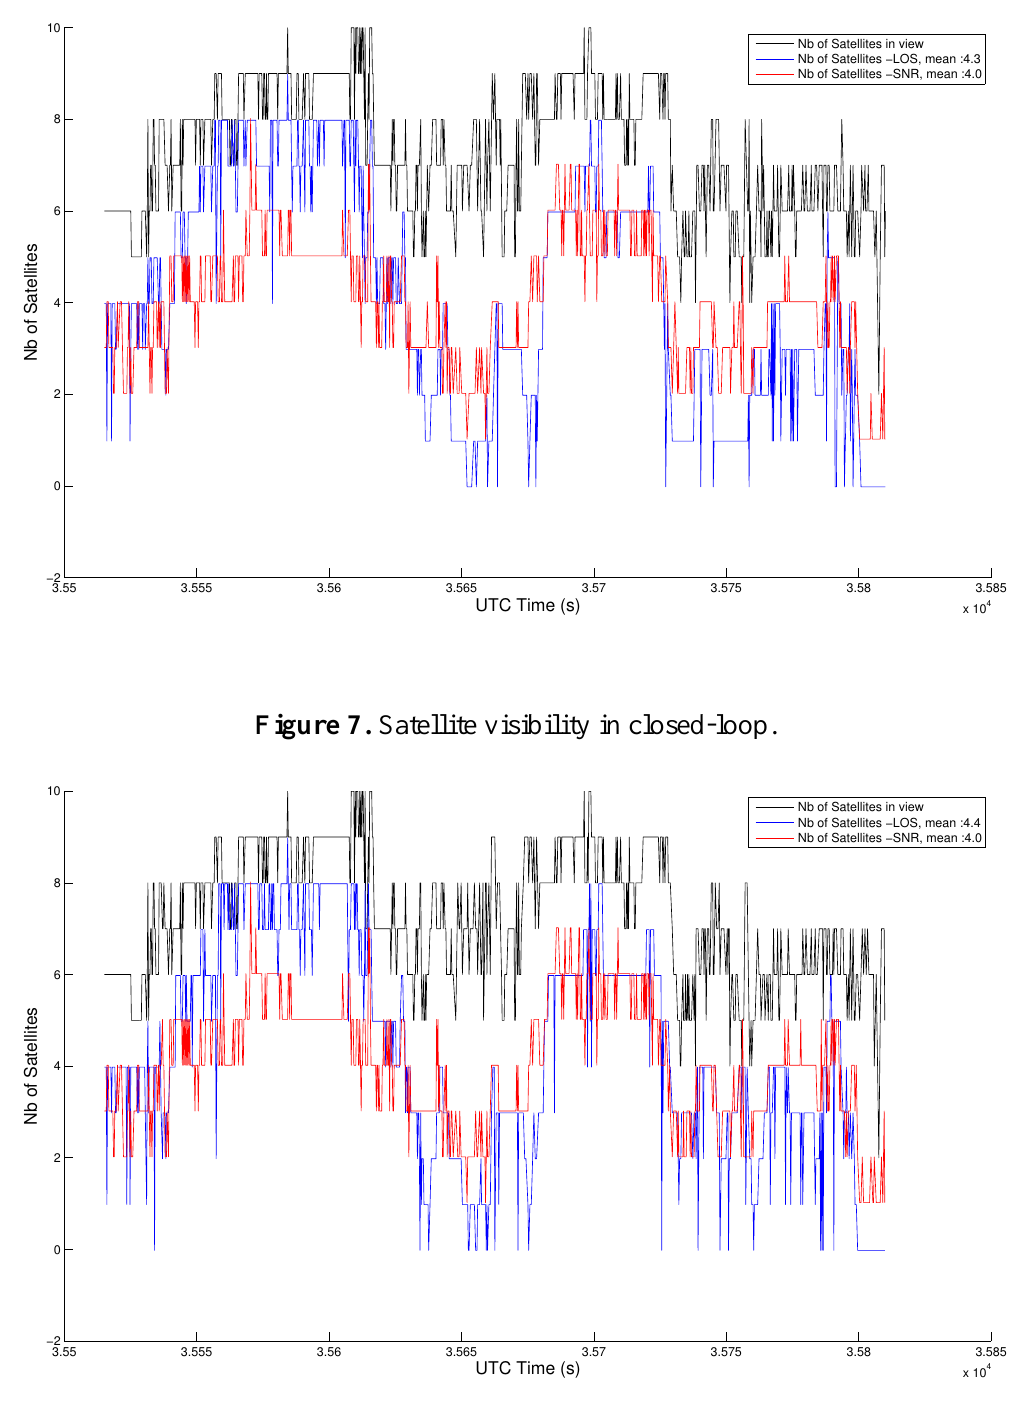
Figure 6. Satellite visibility using GGA map-aided solutions.